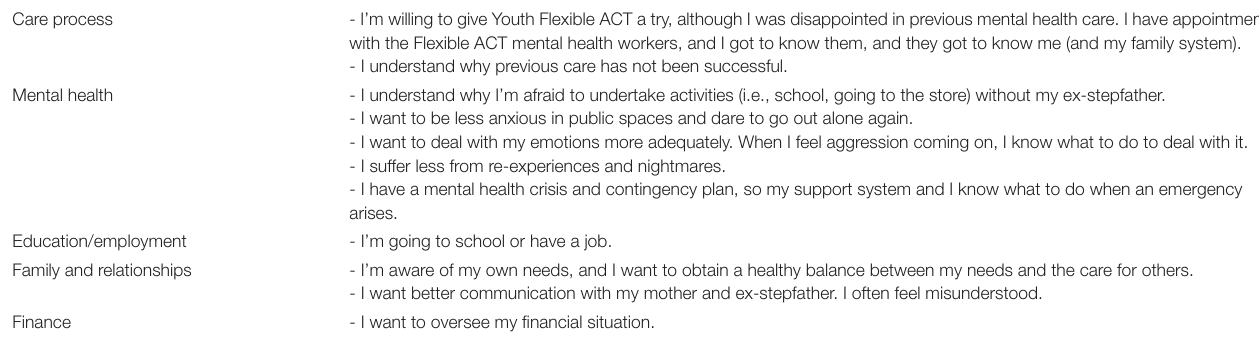
TABLE 3 | Michelle’s treatment goals. Care